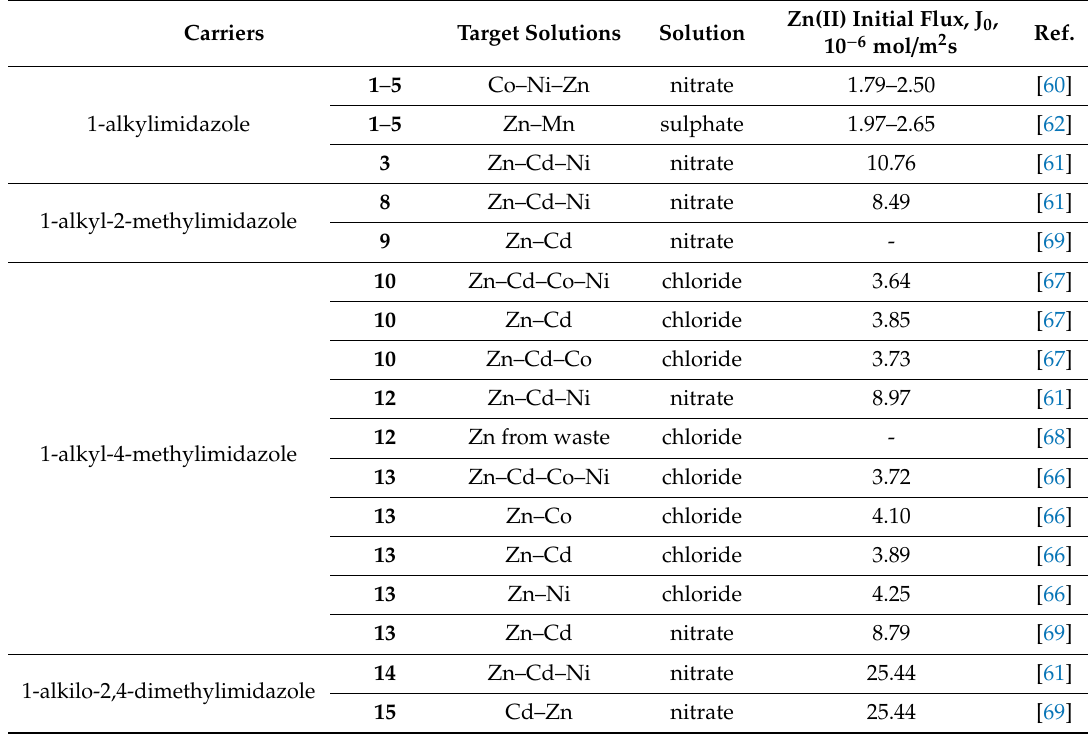
Table 9. An example of the transport of Zn(II) ions across PIMs doped with alkylimidazole derivatives from chloride, nitrate or sulphate solutions reported in the literature. Carriers Target